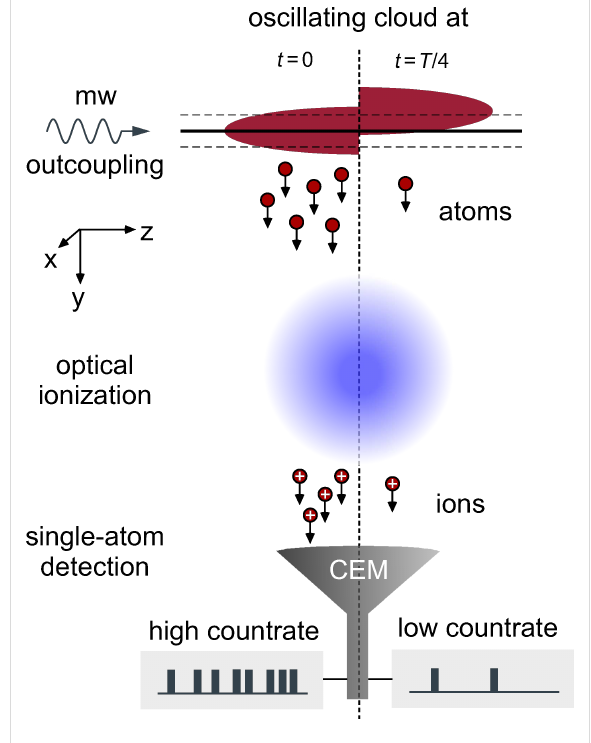
Figure 6: Detecting cloud dynamics. Using microwave radiation, indi- vidual atoms are outcoupled from the cold-atom tip. The outcoupling is strongly localized to the region of resonant microwave coupling (reso- nance sheet), typically shaped flat (black solid line) and tunable via the microwave frequency (dashed solid lines). The outcoupling rate is proportional to the atomic density within the resonance sheet and the total microwave power [51]. Depending on the cloud dynamics, this overlap changes in time, causing a time varying outcoupling rate (left and right half-image). The outcoupled atoms leave the trap and become ionized via a three-photon ionization process with lasers at 778 nm and 1064 nm. The resulting ion beam is captured and guided by ion optics [55] (not shown) and finally detected by a channel elec- tron multiplier (CEM) [56,57]. Individual ions are detected with temporal resolution of 8 ns, allowing for the real-time monitoring of the outcoupling rate and the cloud